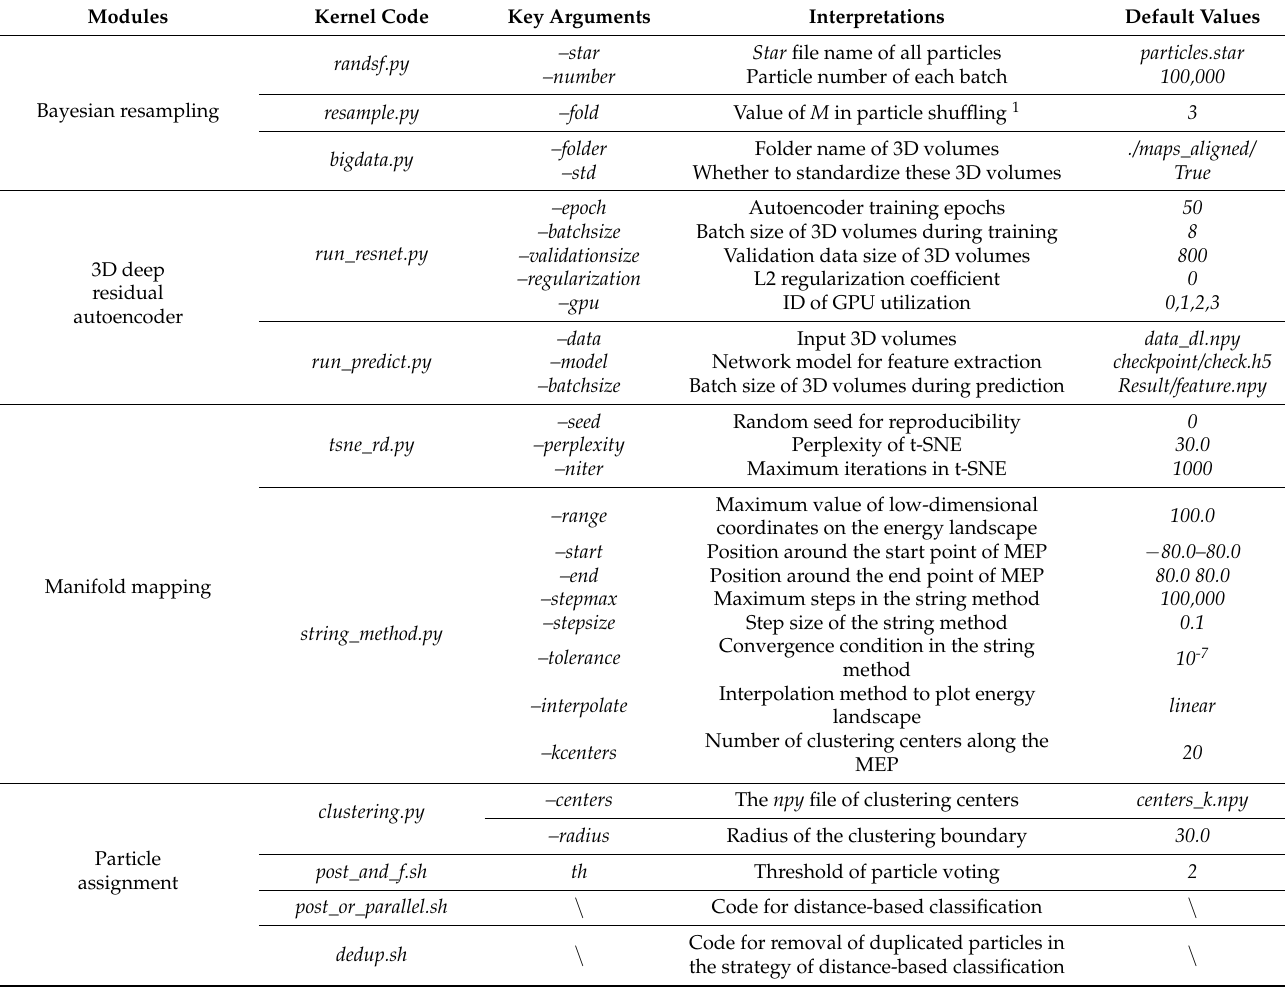
Table 2. Kernel code, key arguments and their interpretations of four modules in